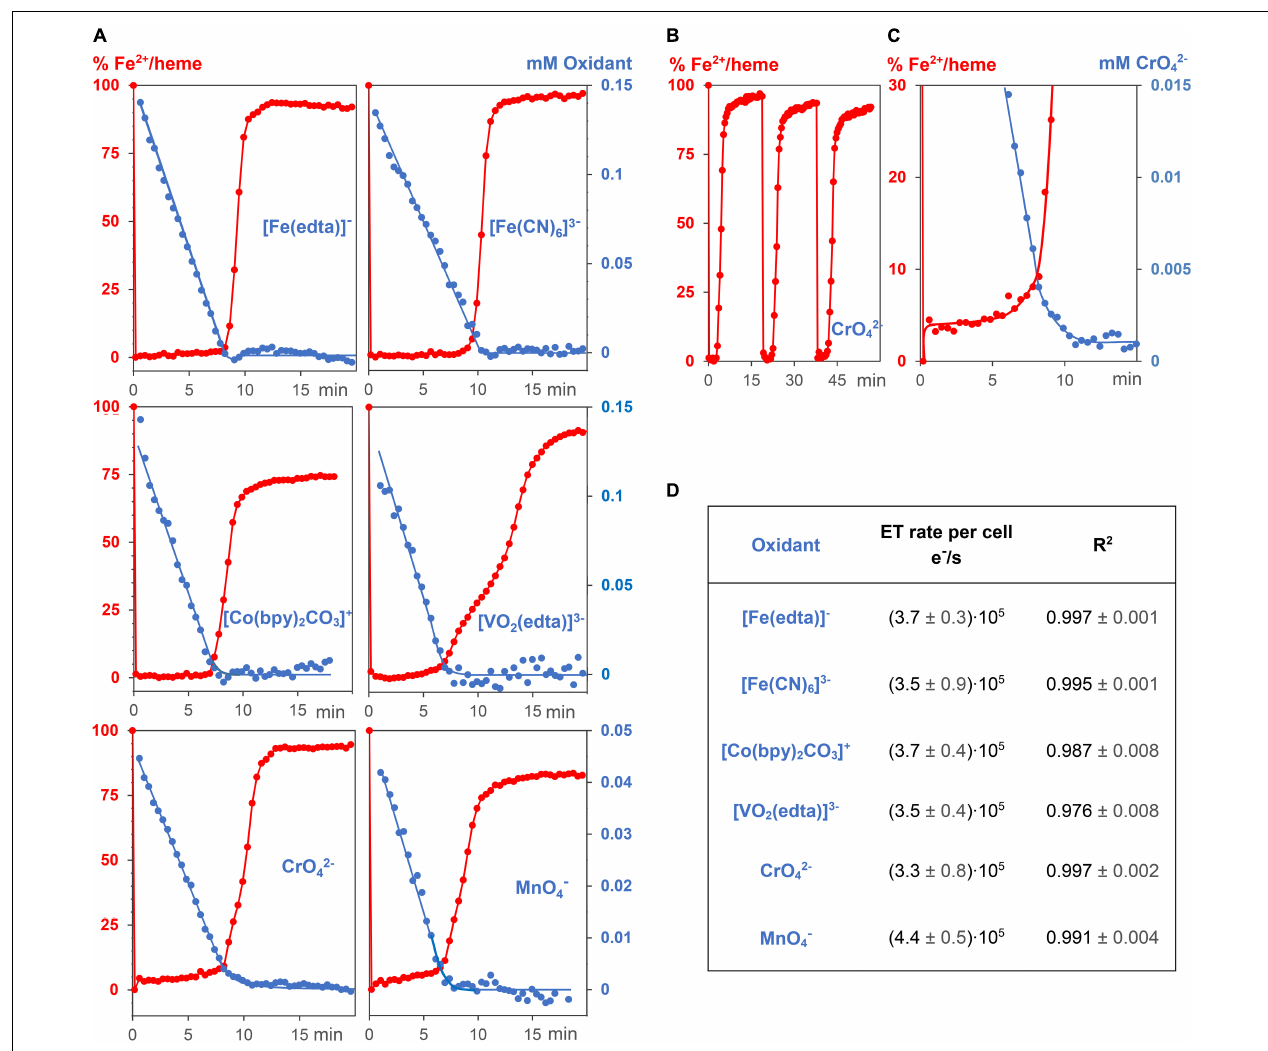
FIGURE 3 | Kinetic experiments of G. sulfurreducens with extracellular metal salts. (A) Reduction of 6 different oxidizing metal salt solutions (blue, 0.05–0.15 mM) with G. sulfurreducens solutions in the resting state (8.9 ± 0.3 pM). Their linear time dependences of the metal salt concentrations demonstrate zero kinetic order of the reduction process. At the start of the experiments, all iron ions of the bacterial multiheme cytochromes were in the Fe 2 + state (red). They were rapidly oxidized upon addition of extracellular metal salts, their levels remained low during reduction of the metal salts, and increased again after major consumption of the oxidants. (B) Experiments could be repeated several times. Shown are Fe 2 + /heme levels upon three consecutive additions of CrO 42 − . (C) A closer look at the Fe 2 + /heme (red) and CrO 42 − (blue) concentrations. The Fe 2 + /heme levels increased after major part of CrO 42 − was reduced, which obviously stabilized EET rates at low concentrations of the extracellular metal salts. (D) Zero order reduction rates per cell for the 6 different metal salts at 30 ◦ C and pH =